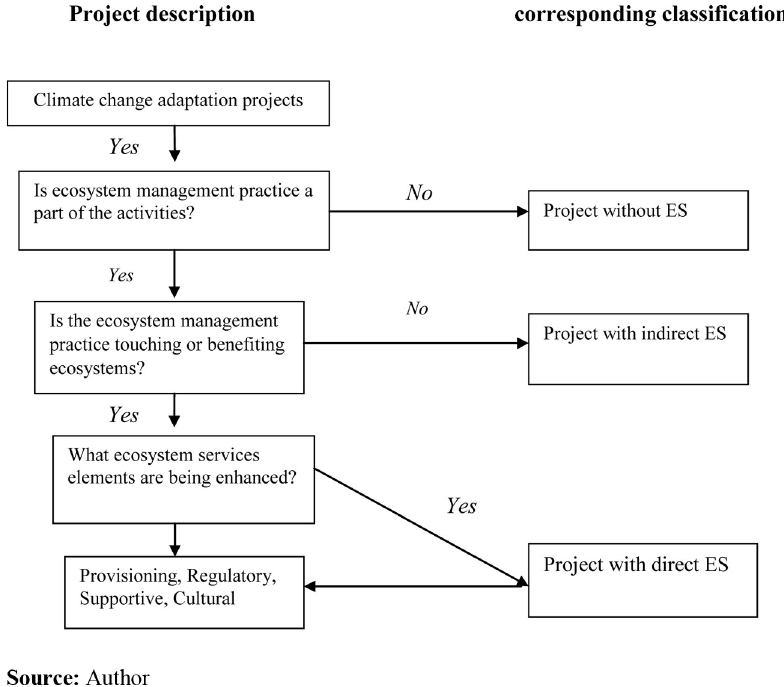
Figure 2 expounds on the project evaluation criteria and corresponding project